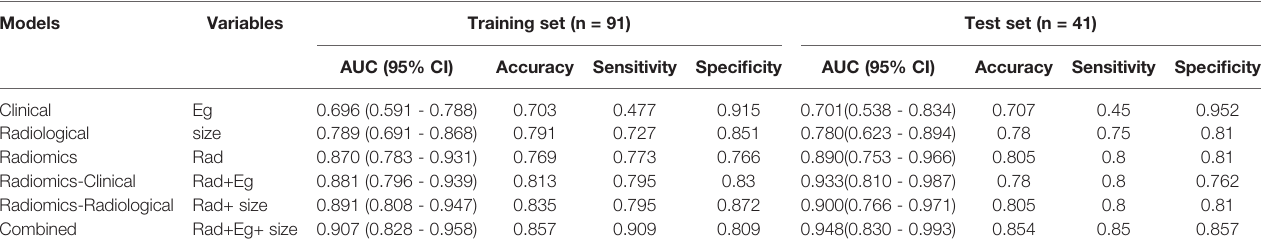
TABLE 4 | Predictive performance of six models in the training and test sets. Models